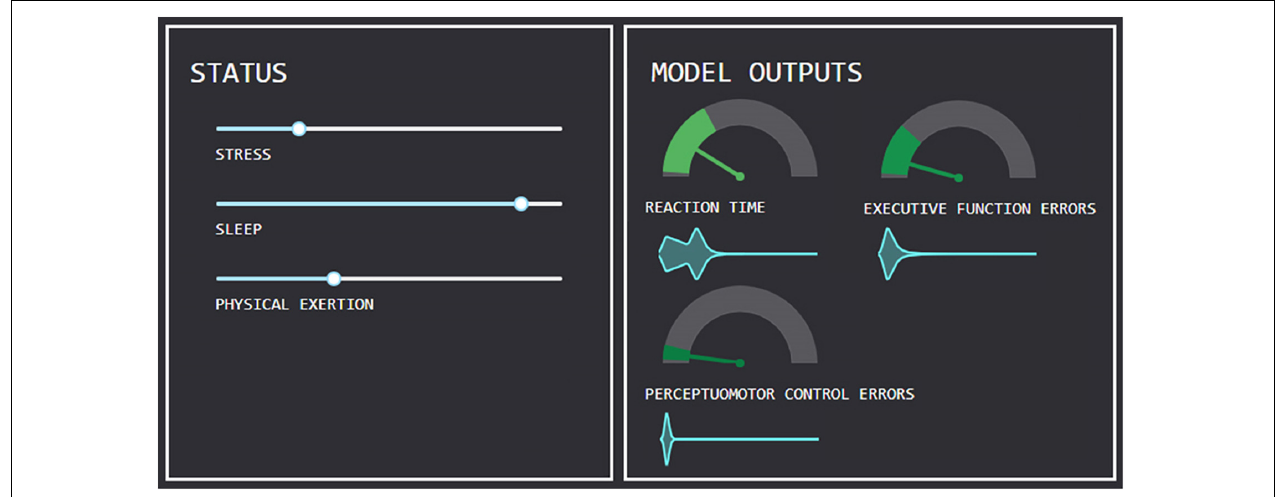
FIGURE 3 | Graphical user interface for a software tool allowing users to interact with computational model, depicting three inputs ( x variables) and outputs ( y variables). Shading surrounding output estimates indicates 95% confidence interval around estimated output.